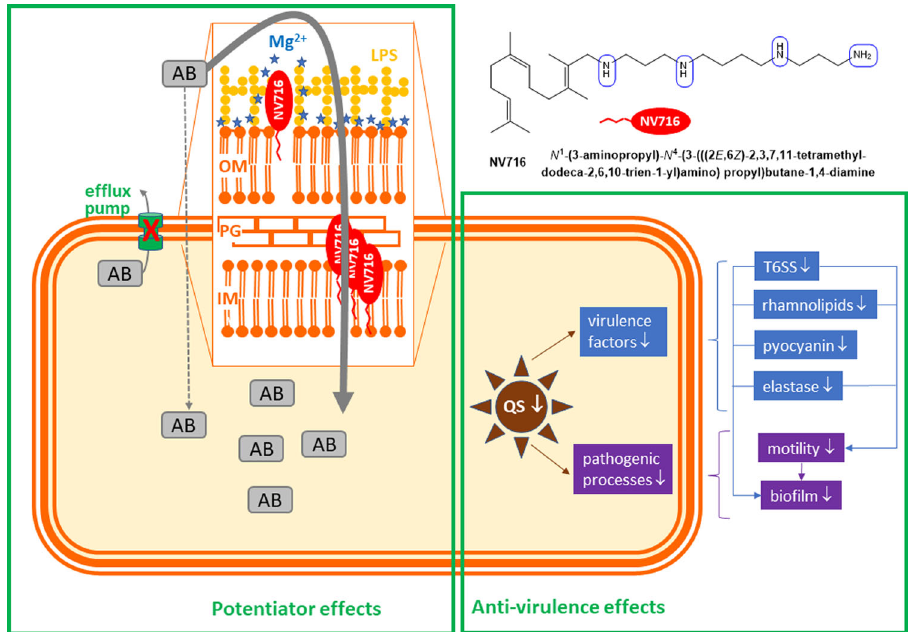
Fig. 10 Model describing the putative mode of action of NV716 as an adjuvant molecule capable of potentiating antibiotic activity and of exerting anti- virulence effects at sub-MIC concentrations. (1) Potentiator of antibiotic activity: At subMIC concentration, NV716 interacts with LPS and increases the permeability of the outer membrane of P. aeruginosa , while at the same time inhibiting the activity of ef fl ux transporters by an unknown mechanism 13 , which facilitates the penetration of antibiotics. At its MIC, it also permeabilizes the inner membrane of the bacteria, leading to their death without gross alteration of the bacterial morphological integrity. (2) Anti-virulence compound: It also reduces the expression of quorum sensing-related genes, causing a downregulation of virulence factors like rhamnolipids, pyocyanin, elastase, and of T6SS-related genes, as well as a subsequent reduction in motility and bio fi lm formation. The chemical structure of NV716 is also shown, with the aminated functions (protonable at physiological pH) circled in